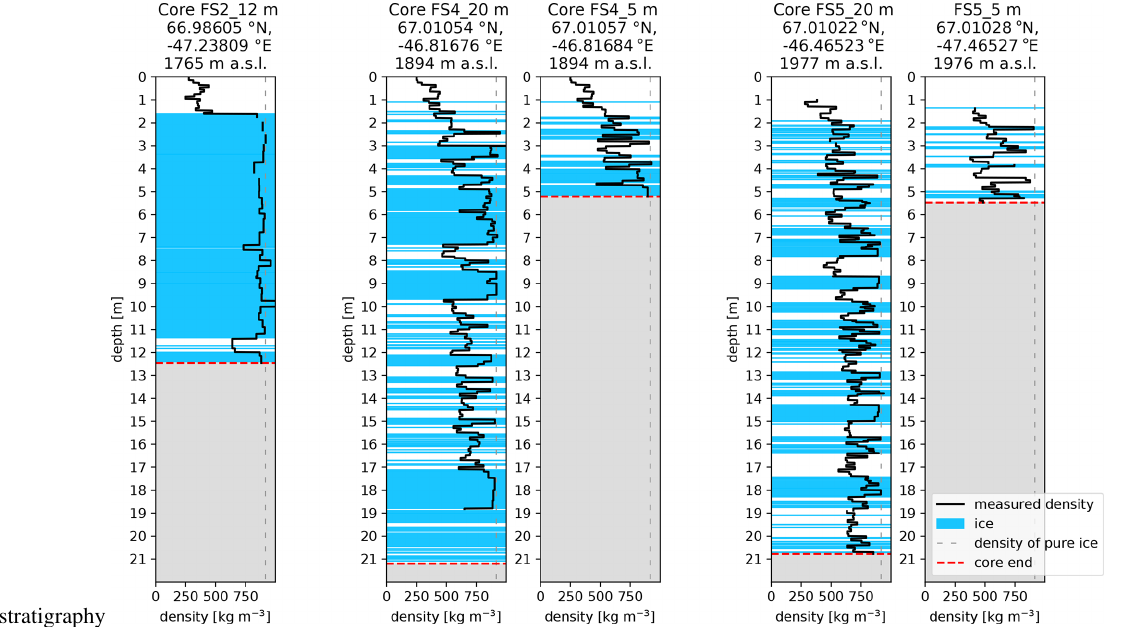
Figure 4. Firn stratigraphy at the three field sites as measured in spring 2021. Core logs are displayed W–E or low–high altitude from left to right. Core FS2_12 is at the location of the 2020 summer field measurements, whereas the meltwater percolation experiments carried out in spring 2021 are co-located with Core FS4_20m and Core FS4_5m (see Fig.